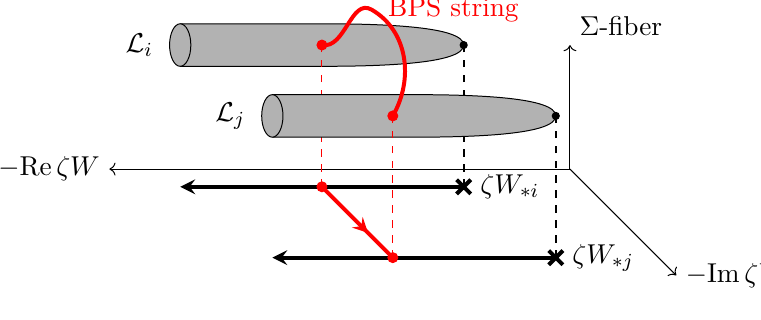
Figure 5 . Lefshetz